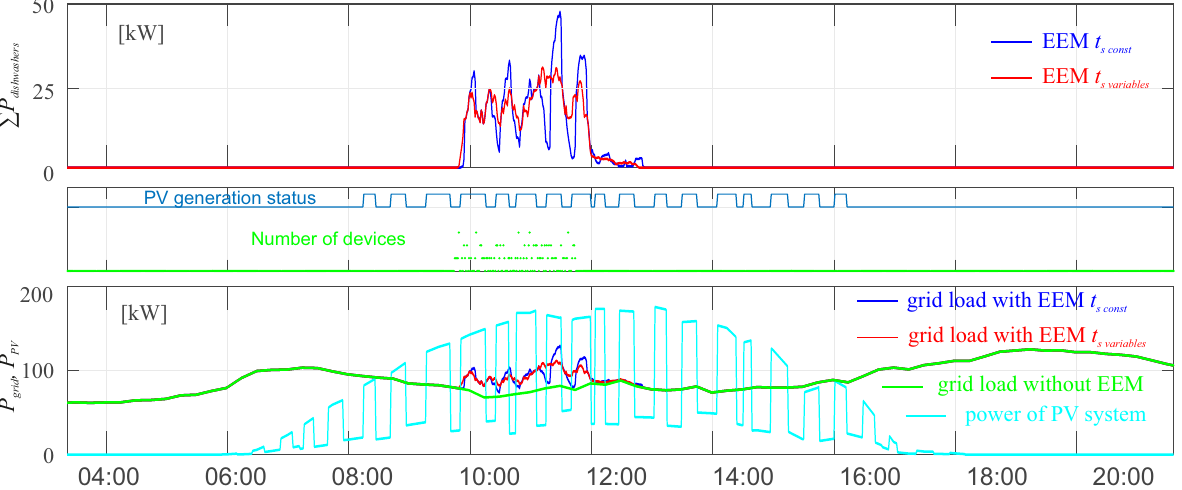
Figure 11. Numerical experiment of electric power systems with PV installation and the elastic energy management algorithm for 100 washing machines.